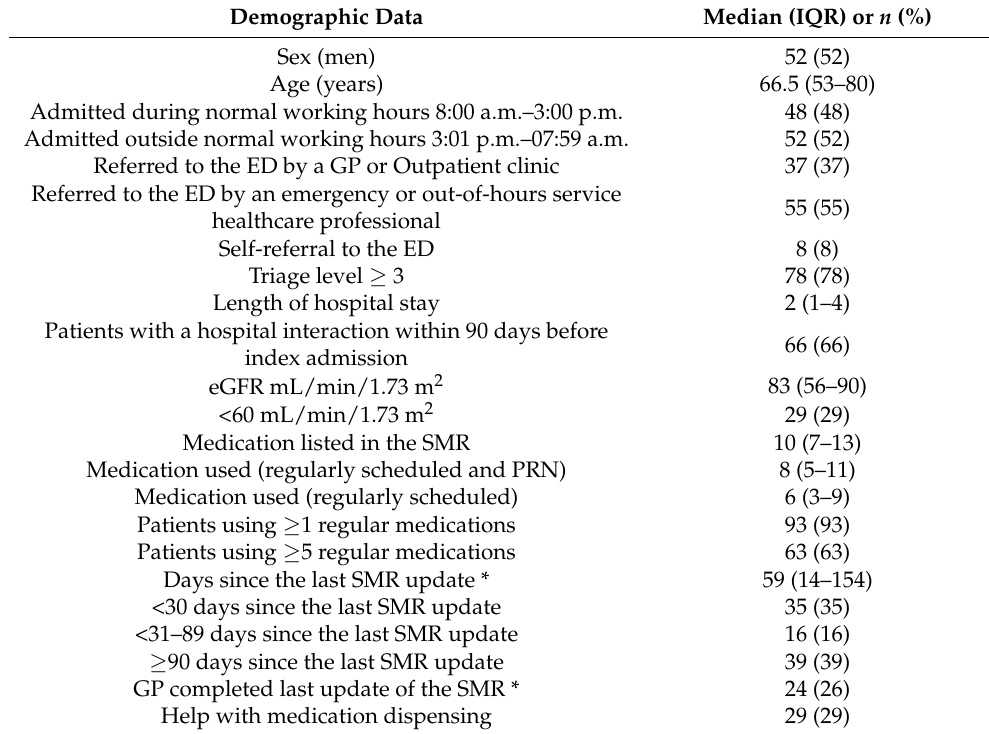
Table 1. Patient characteristics of the included patients ( n =